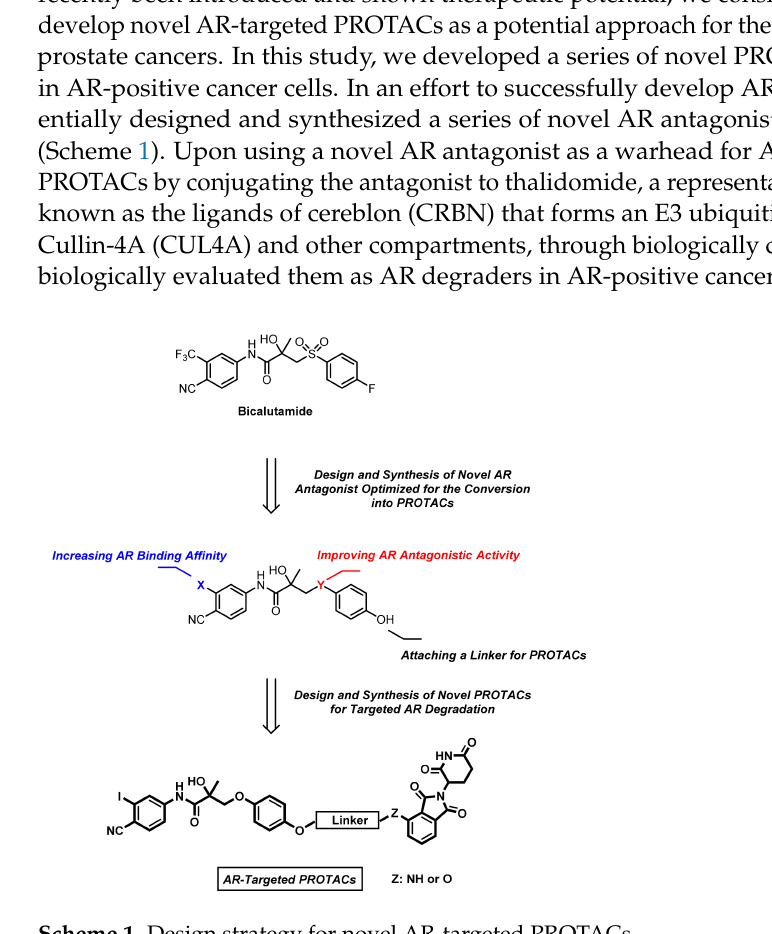
Scheme 1. Design strategy for novel AR-targeted